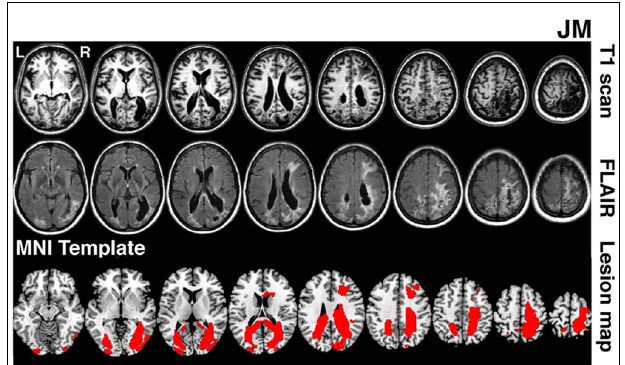
FIGURE 1 | Lesion reconstruction for patient JM. The figure depictsT1 andT2 FLAIR structural scans (3T Philips Achieva MRI system with 8-channel phased array SENSE head coil).The bottom panel represents patient’s lesion map reconstructed based on outlier detection method combined with fuzzy clustering algorithm (see Seghier etal., 2008; Chechlacz etal., 2012).The lesion map is presented as an overlay on a standardT1 multi-slice template in MRIcron (Chris Rorden, GeorgiaTech, Atlanta, GA, USA). L = Left and R = Right hemisphere.